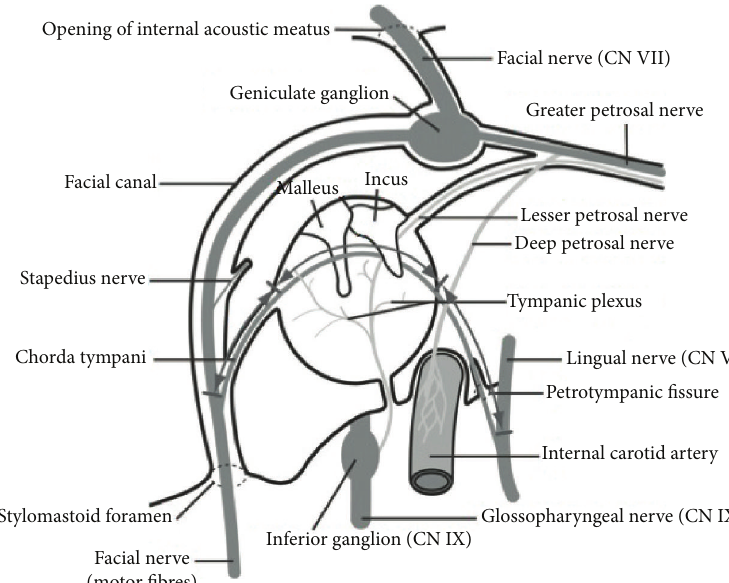
Figure 3: Diagram of the course of the intratemporal facial nerve from the fundus of the IAC to the stylomastoid foramen [10].